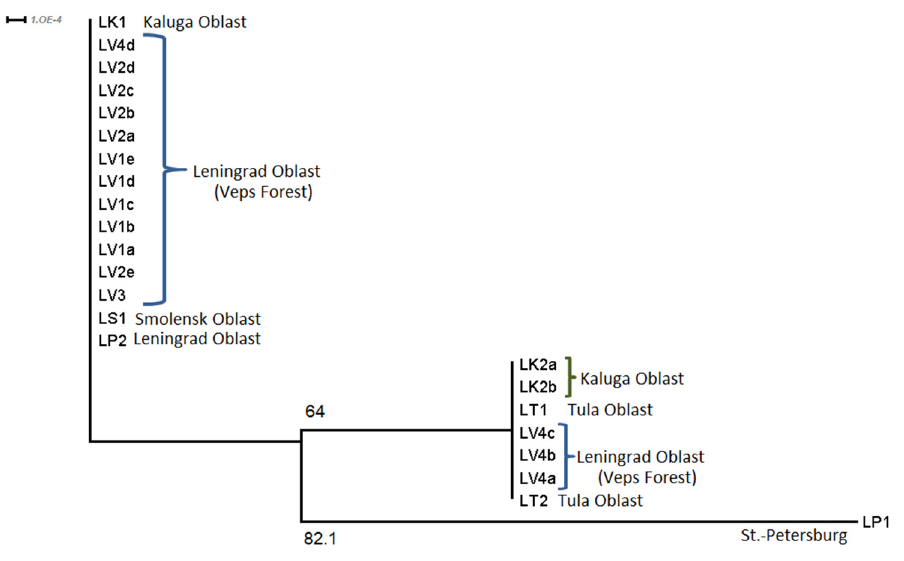
Figure 5. The UPGMA tree of Lupinus polyphyllus from different parts of its secondary distribution range.